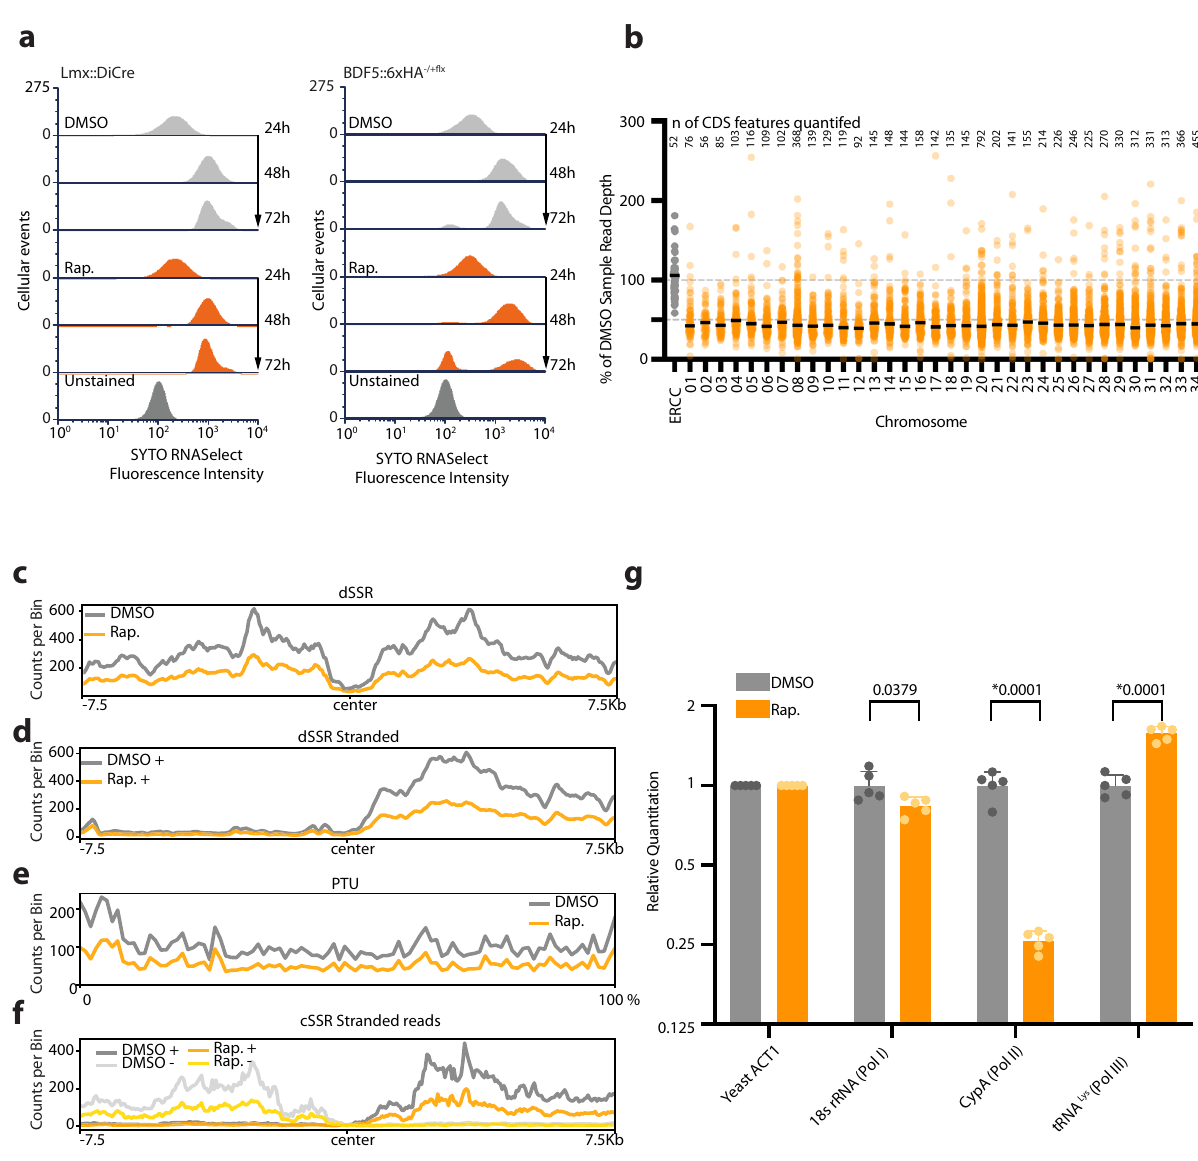
Fig. 6 Effect of BDF5 depletion on RNA levels and gene expression. a Flow cytometry of cells stained with SYTO RNASelect Stain to measure total RNA levels in Lmx::DiCre strains or the BDF5 − / + fl x strain treated with rapamycin or DMSO over a 72 h time course. 20,000 events measured per condition. b Dot plot of total RNA-seq reads per protein-coding gene scaled to ERCC spike-in controls, then as a percentage of the DMSO control sample, separated per chromosome, conducted at a 96 h timepoint. Black lines denote the median of the scaled response for each chromosome, individual data points